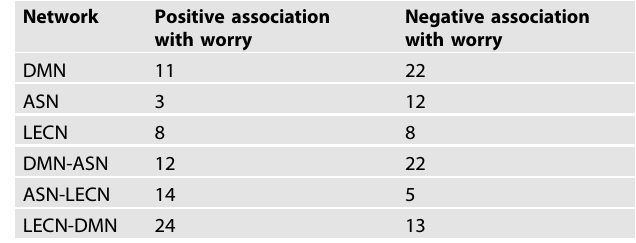
Table 2. Distribution of relevant connectivities identi fi ed by HC within and between the networks.